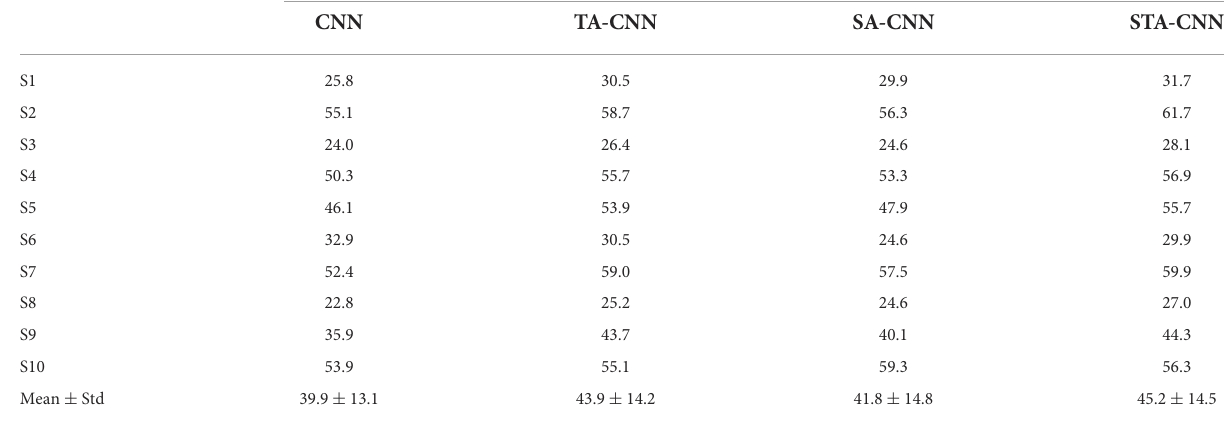
TABLE 4 The total classification accuracy of 10 subjects for the ablation study